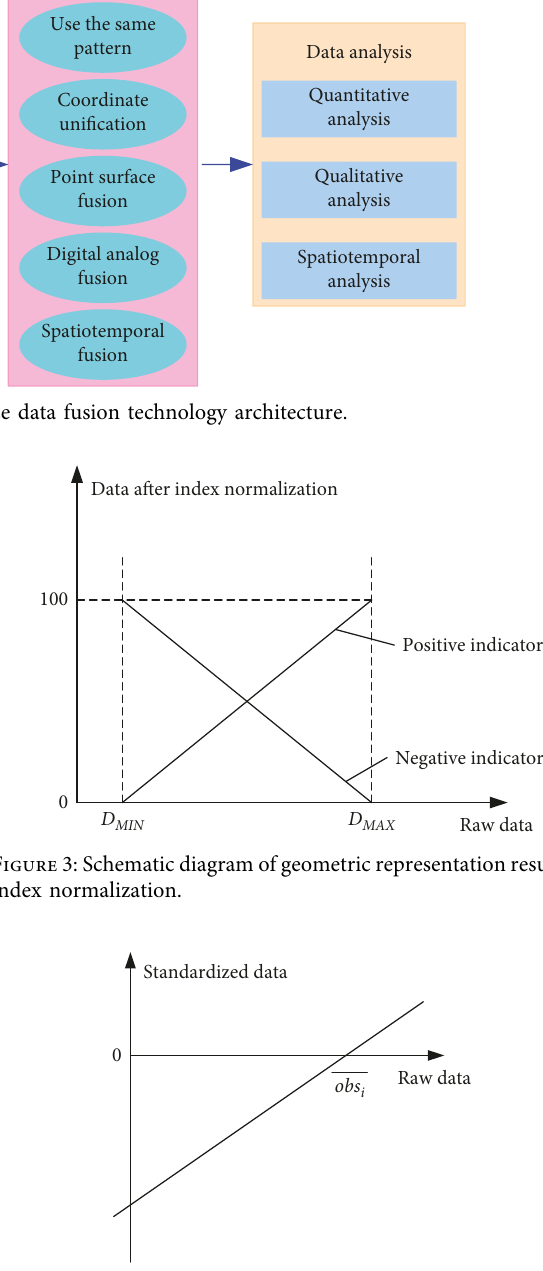
Figure 4: Schematic diagram of geometric representation results of index standardization.